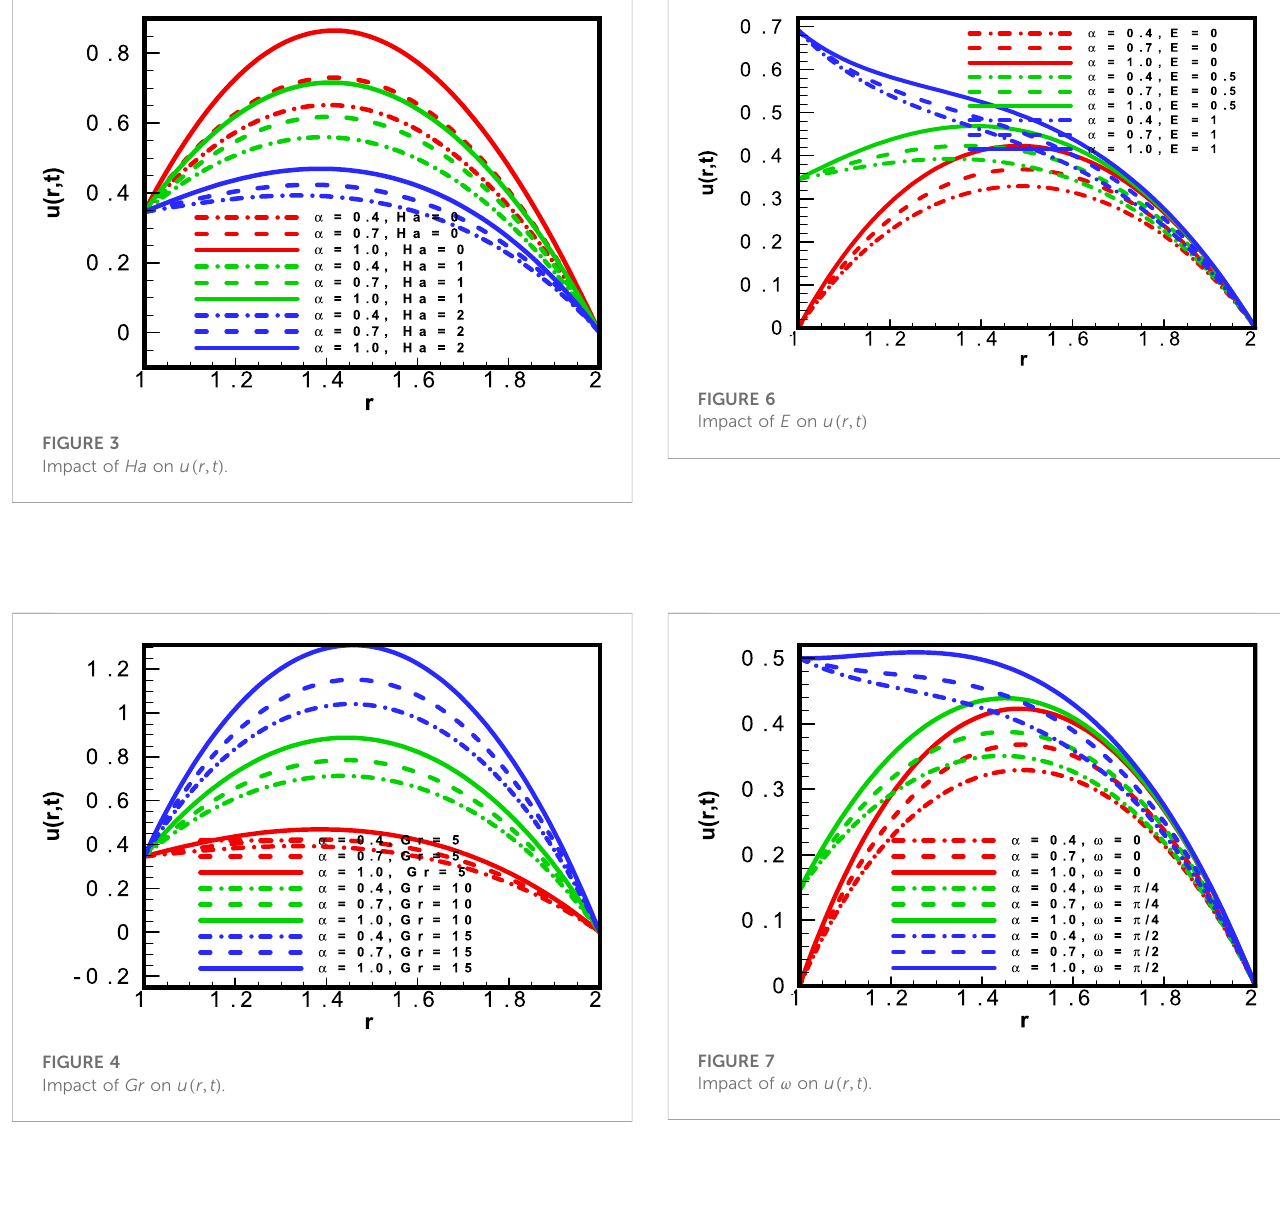
FIGURE 4 Impact of Gr on u ( r , t ) .